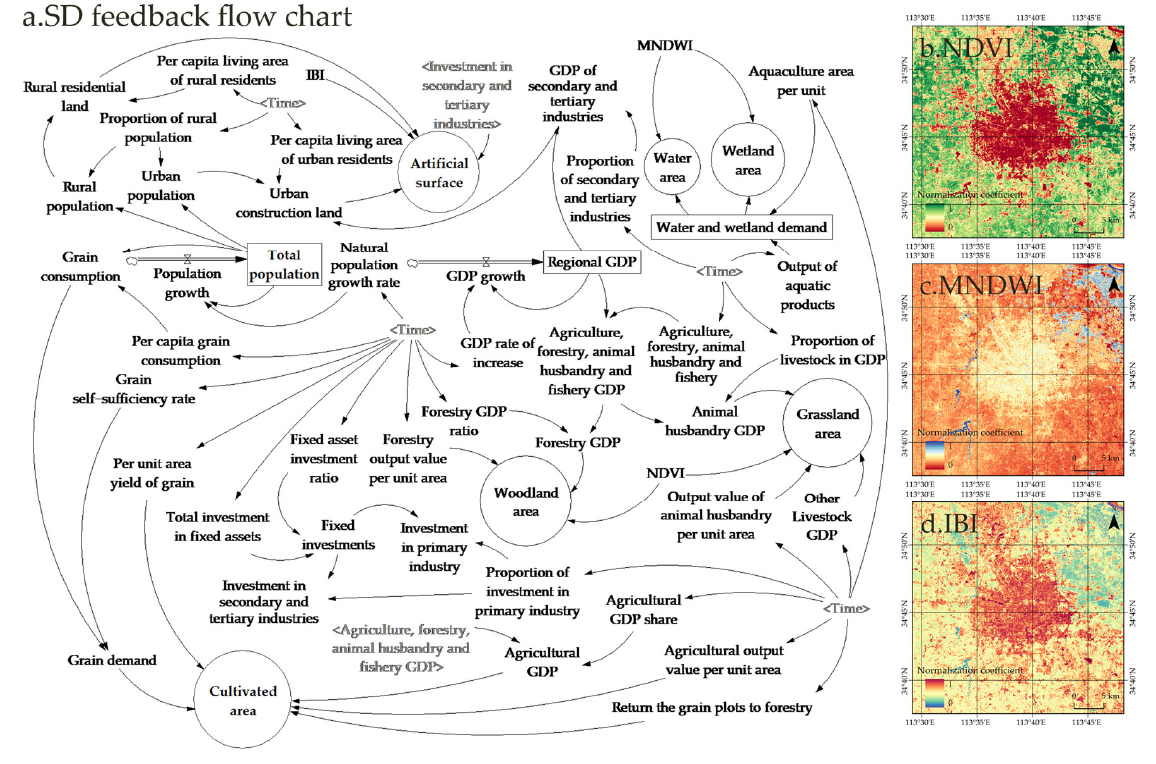
Figure 4. SD model feedback flow diagram.